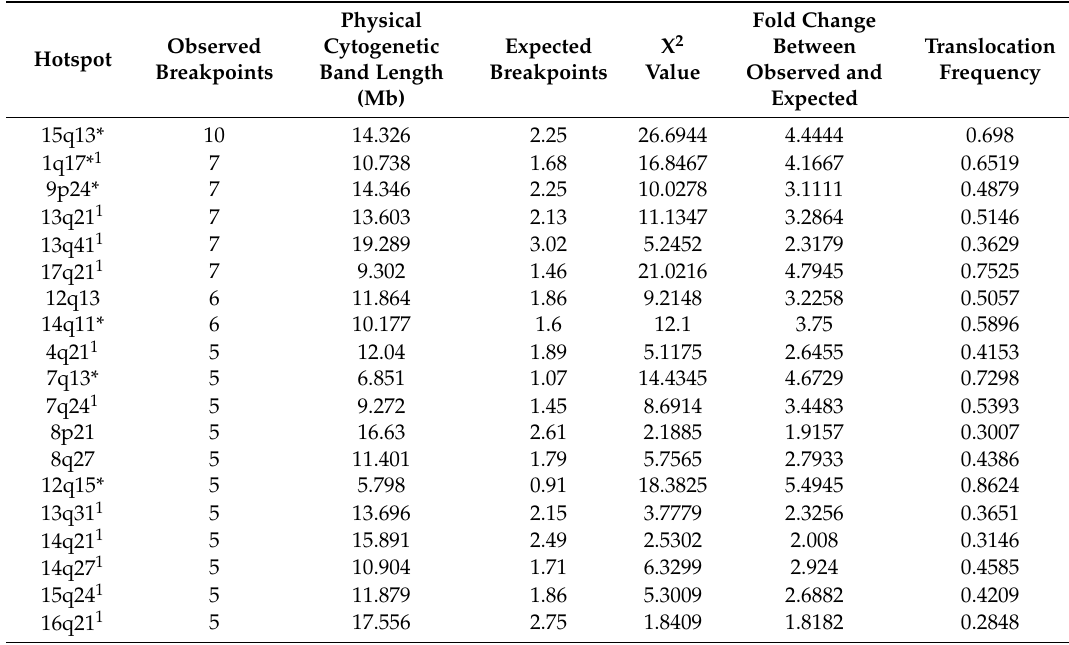
Table 10. Suggested hotspots for rearrangement in the pig genome based on breakpoint number.